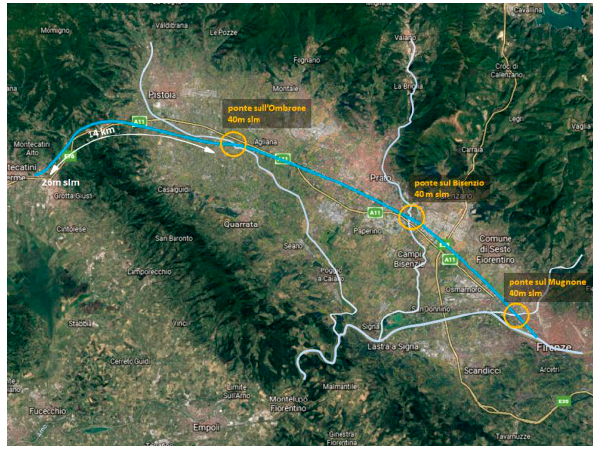
Figure 16. Satellite view of the plain between Florence and Pistoia with the route of the canal and the crossing of the tributaries of the Arno.